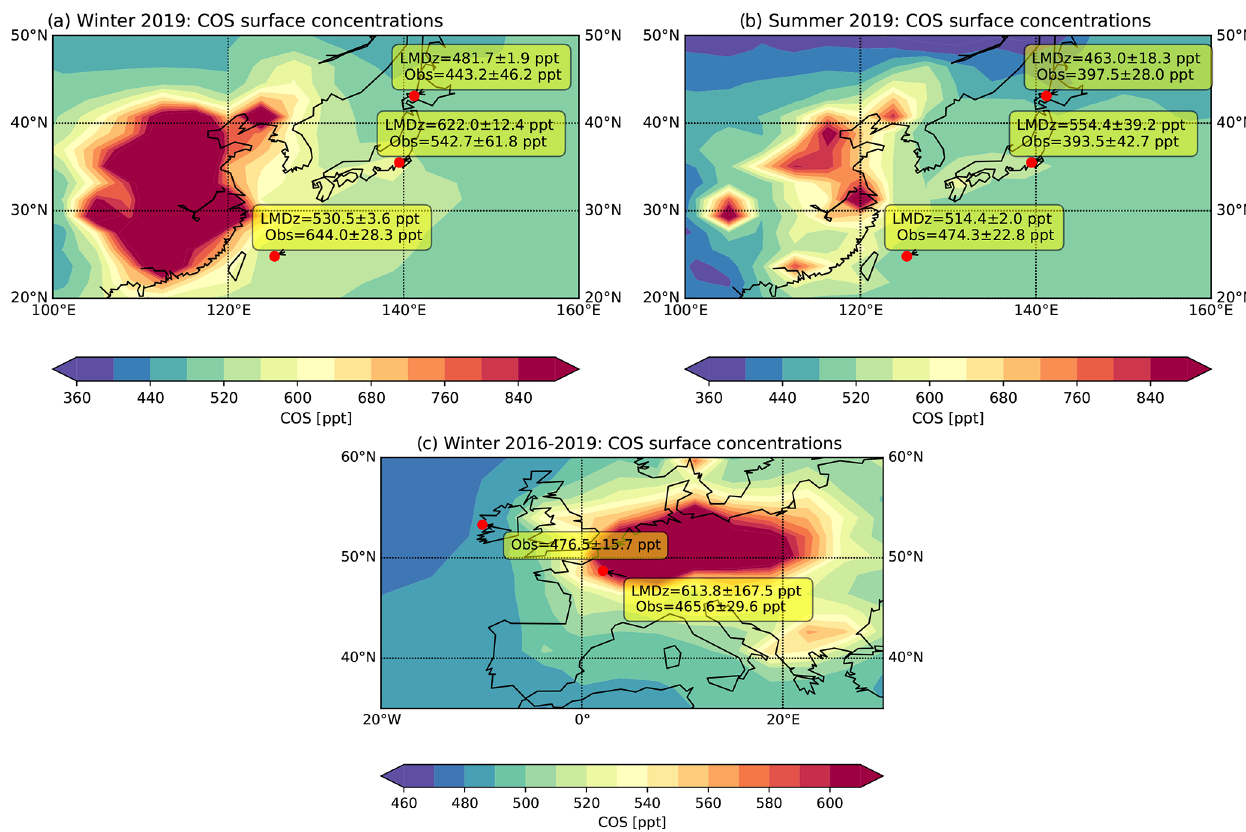
Figure 11. Mean COS concentration sampled at the first level of the LMDz model in (a) winter 2019 (February, March), (b) in summer 2019 (July–August) and (c) in winter (December–February) during the period 2016–2019. The values within the yellow frames correspond to the mean COS observed and modelled COS concentrations and their standard deviation at four surface sites: Miyakojima (24 ◦ 80N, 125 ◦ 27E), Yokohama (35 ◦ 51N, 139 ◦ 48E), Otaru (43 ◦ 14N, 141 ◦ 16E) and GIF (48 ◦ 42 (cid:48) N–2 ◦ 08 (cid:48) E). The station MHD has been assimilated and is shown here as a